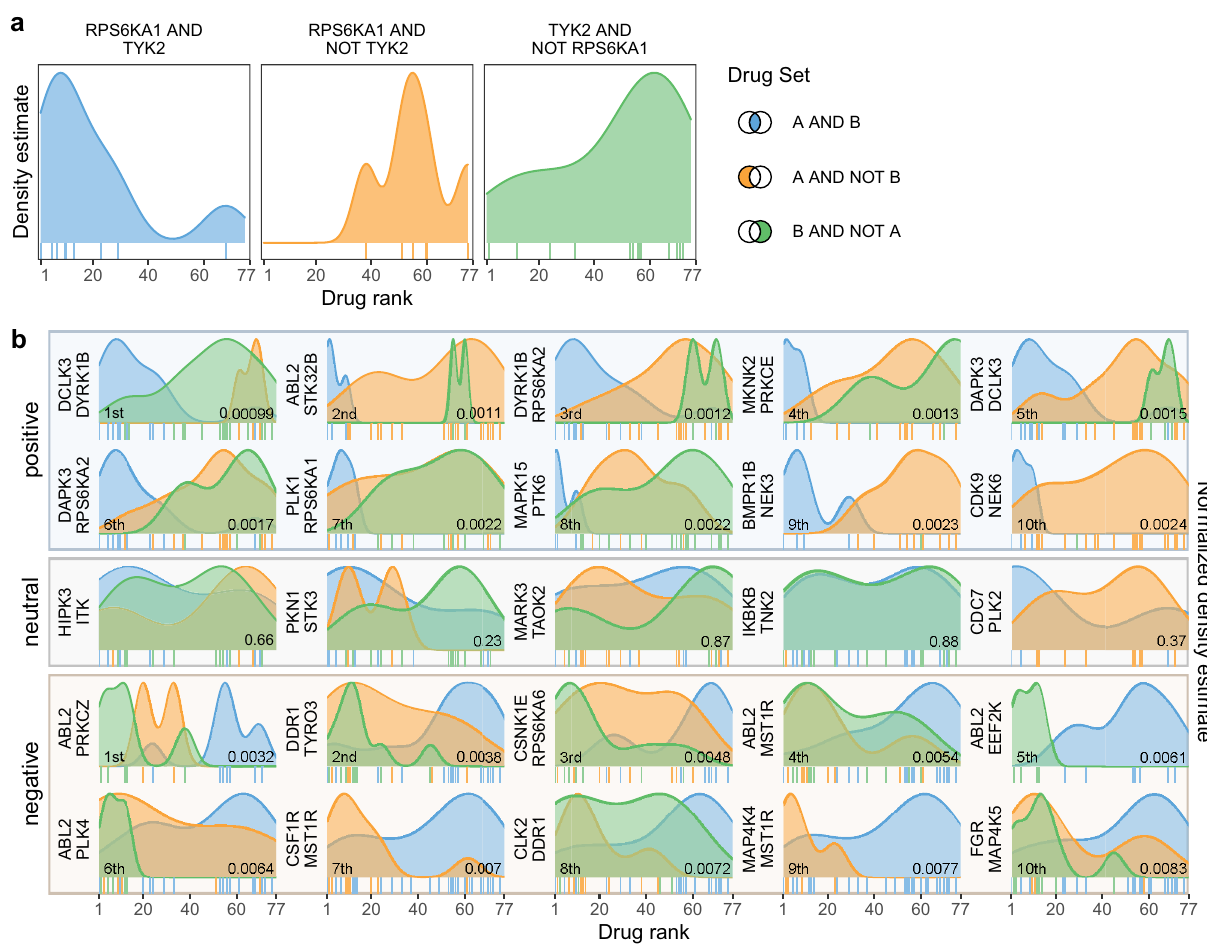
Fig. 5 Analysis of polypharmacology effects among the top-scoring drugs. a An example polypharmacology test with a focus on RPS6KA1 and TYK2. The drugs are ranked by the harmonic mean p -value (as in Figs. 3 and 4), and the distributions of drugs bindings to both RPS6KA1 and TYK2 (left), those binding to RPS6KA1 but not TYK2 (middle) and, conversely, TYK2 but not RPS6KA1 (right) are shown along this ranking. Individual drugs that bind those targets are annotated by vertical tick marks directly below the corresponding distribution. b Top ten positive and top ten negative interactions between pairs of targets. The distributions in each plot are compared using Wilcoxon Rank Sum test, with the resulting p -value presented in the bottom right corner. If compounds that bind both targets appear signi fi cantly closer to the top of the ranked list (left side of the x axis), we de fi ne the target pair to be a positive interaction. Conversely, a pair of targets with an explicit non-binding interaction observed among the top-ranking compounds is de fi ned to be antagonistic. A set of fi ve neutral target pairs (i.e., no signi fi cant positive or negative effect) is included for reference.